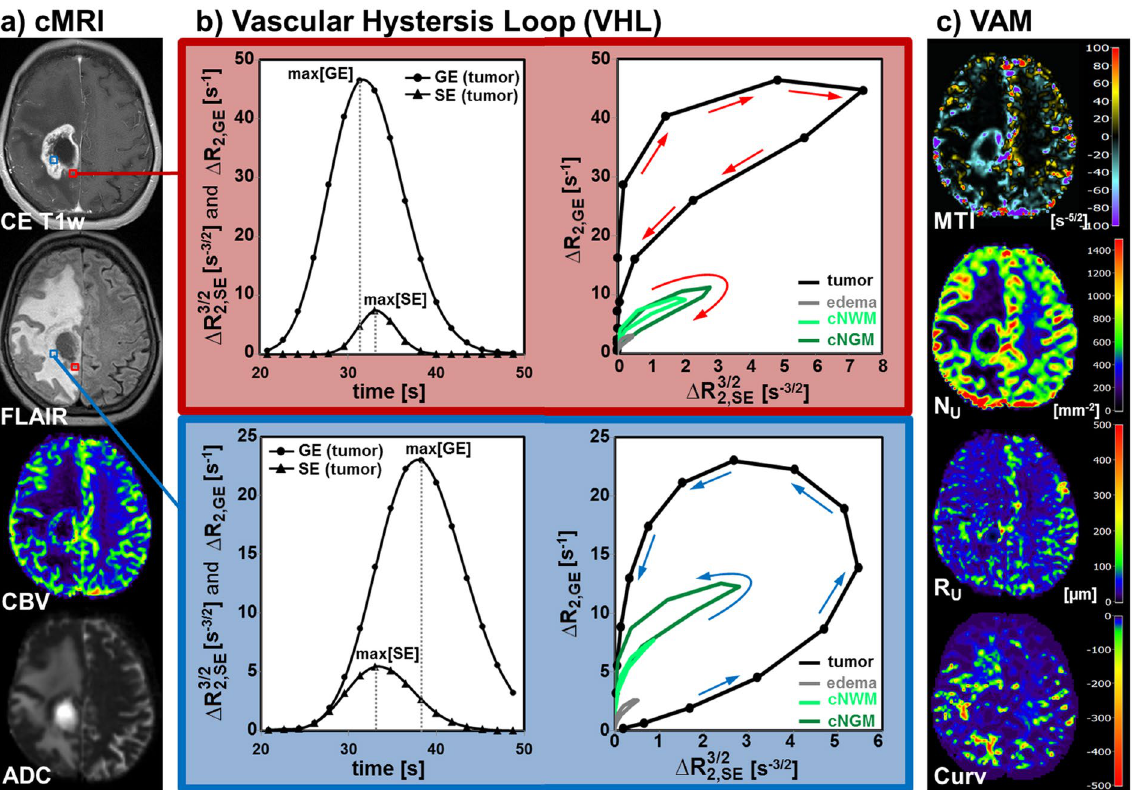
Figure 1. Calculation of vascular hysteresis loops and VAM biomarker maps for a 63-year-old female patient suffering from a recurrent glioblastoma. The presented data were obtained from an examination which was performed before onset of bevacizumab treatment (baseline examination). ( a ) Conventional MRI (cMRI) included contrast-enhanced T1-weighted (CE T1w), FLAIR, GE-EPI DSC perfusion evaluated as maps of cerebral blood flow (CBV), and DWI evaluated as apparent diffusion coefficient (ADC), respectively. ( b ) The Δ R(t) ∆ t R( ) 2,SE3/2 curves for the first bolus of the GE- and SE-EPI DSC data, respectively, were fitted to a 2,GE and gamma-variate function (left) and used for calculation of the vascular hysteresis loops (VHLs, i.e. the ∆ R versus ∆ R 2,SE3/2 diagram, right). The red-framed part shows bolus curves and VHLs for a voxel position (red squares in a) with arterial-dominated microvasculature, and the blue-framed the analogue for a voxel position (blue squares in a) with venule/capillary-dominated microvasculature. The arrows indicate the rotational direction of the VHLs. ( c ) The maps of the microvessel type indicator (MTI), the upper limit for microvessel density (N U ) and radius (R U ) adapted to the temporal shift phenomenon, and the curvature (Curv) of the VHL (top-down). The color codes are depicted at the right image